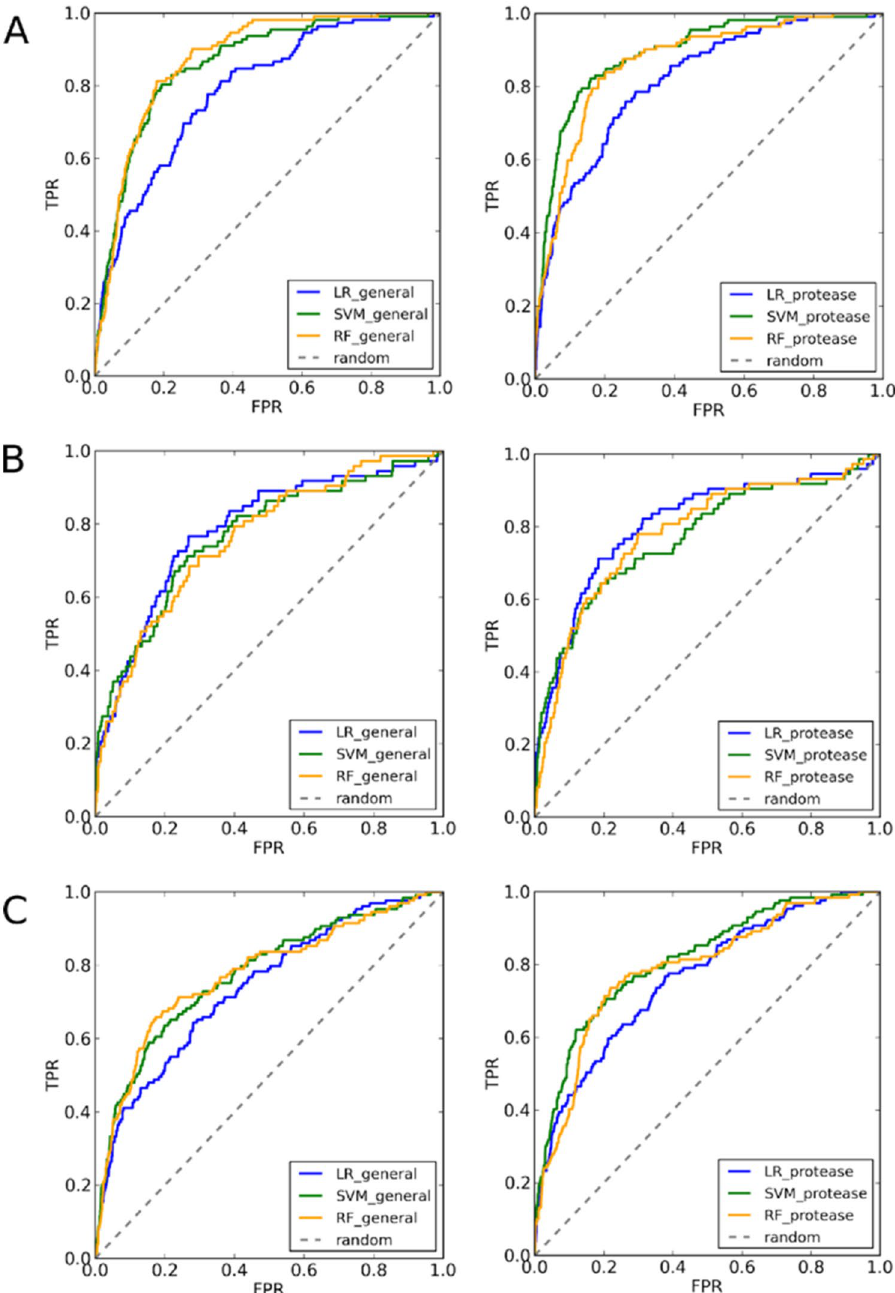
Figure 5. AUC ROC curves of the general (left) and protease-specific scoring functions (right) trained with MLR, SMOreg and RF for the FA7 ( A ), RENI ( B ), and UROK ( C ) datasets from